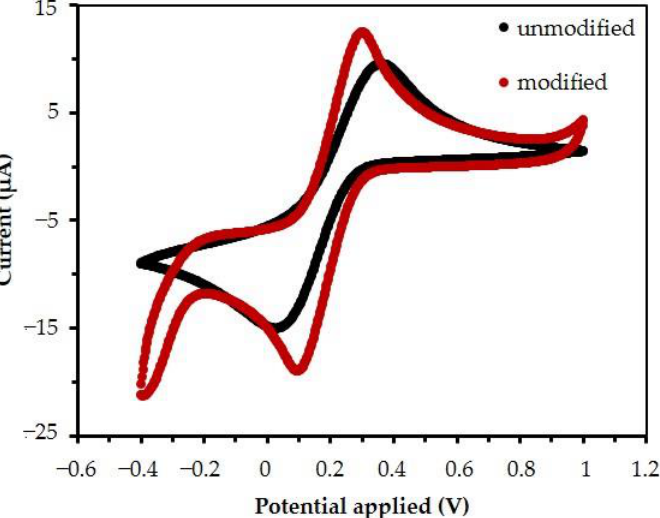
Figure 6. Cyclic voltammogram of the modified and unmodified electrode in 5 mM K 3 Fe(CN) 6 and adding 0.1 M KCl scanned at 20 mV / s.